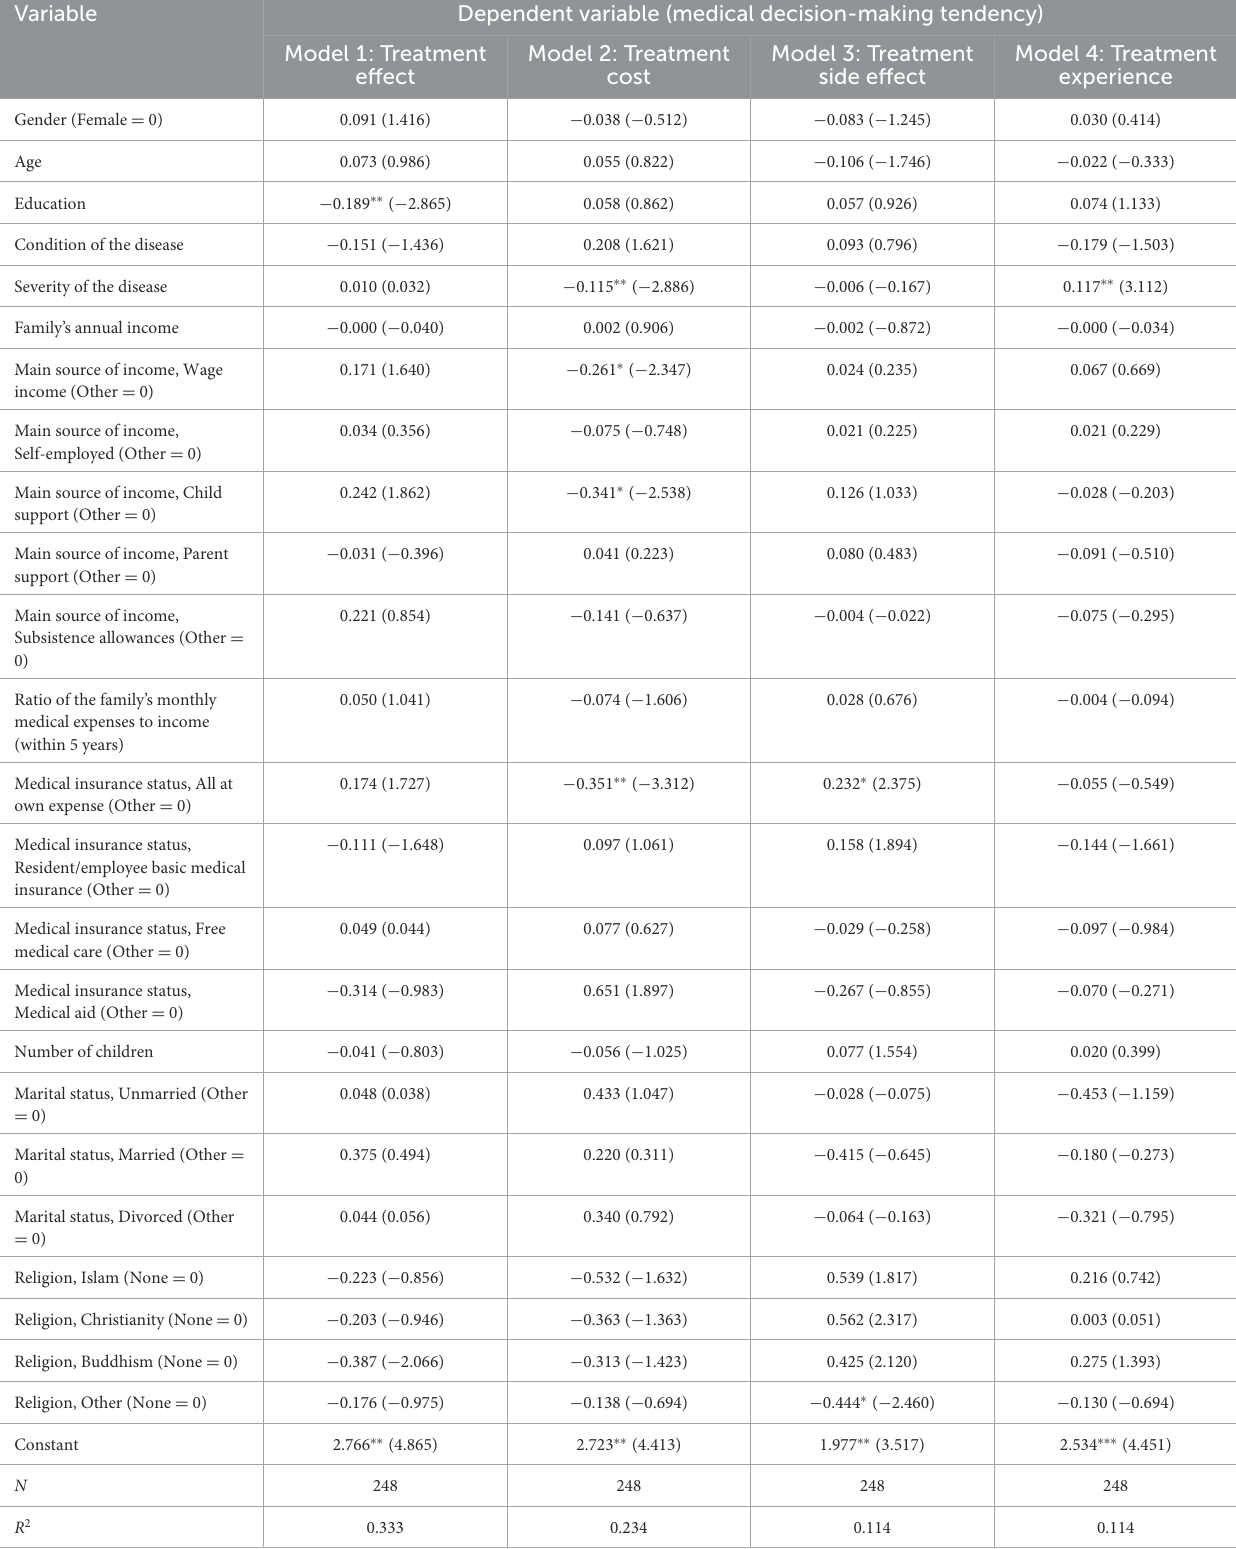
TABLE 2 Regression analysis of patients’ choice tendency in medical